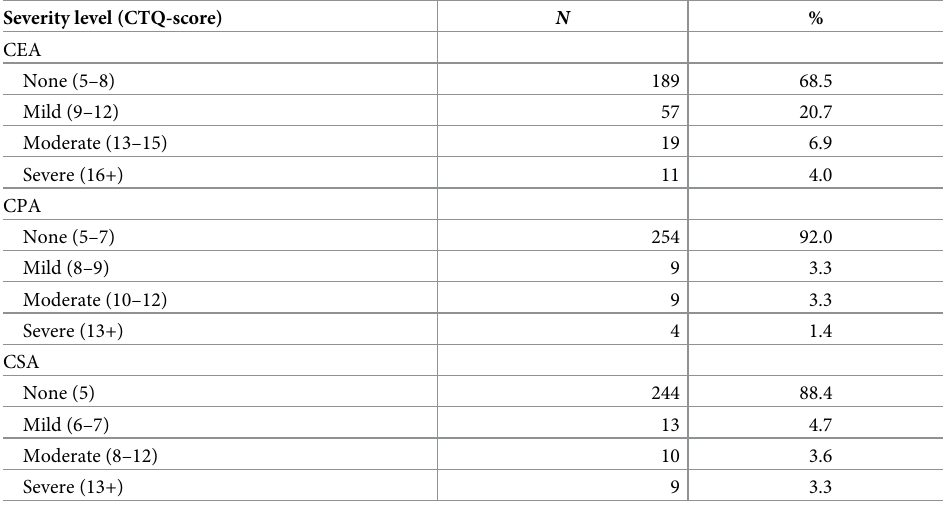
Table 2. Severity levels of three types of childhood abuse in female college students ( N =